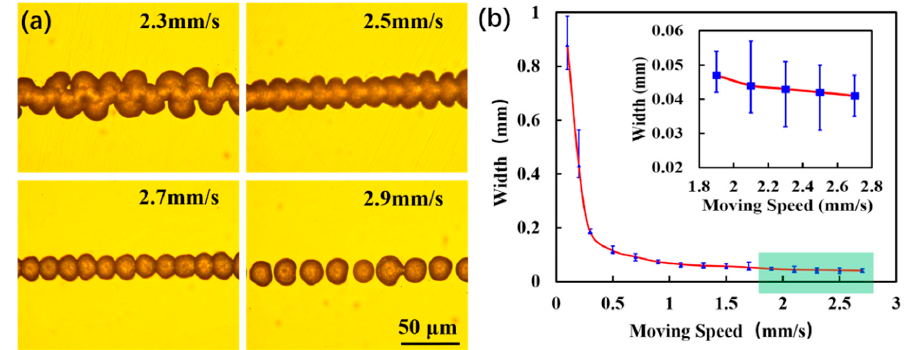
Figure 5. ( a ) Microscopy images of wax droplets patterns on the collecting plate at different